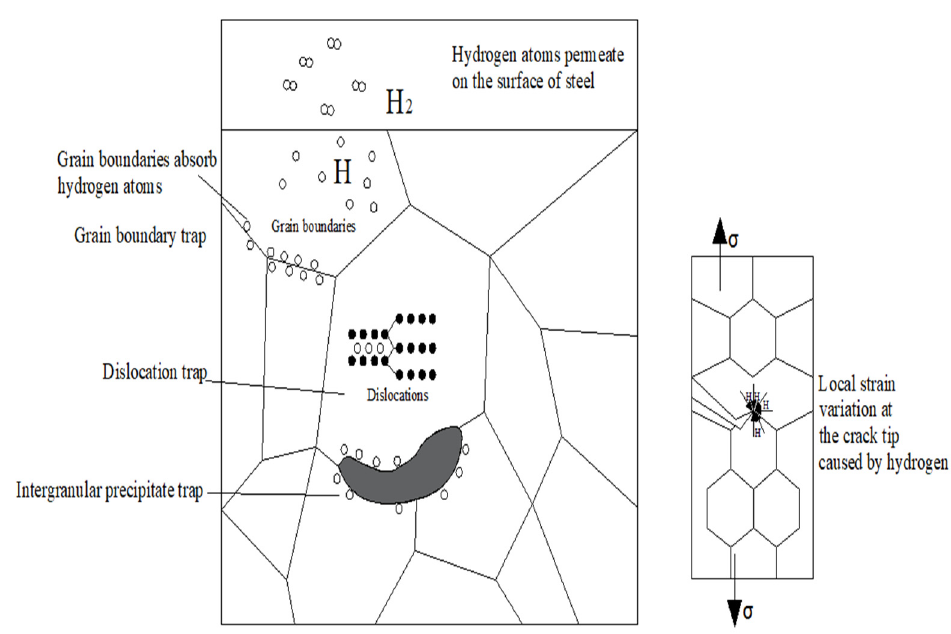
Figure 11. Hydrogen trap forms of steel.